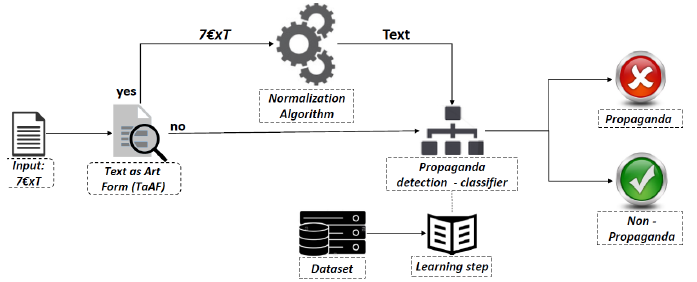
Figure 2. Research approach: data management, phases and